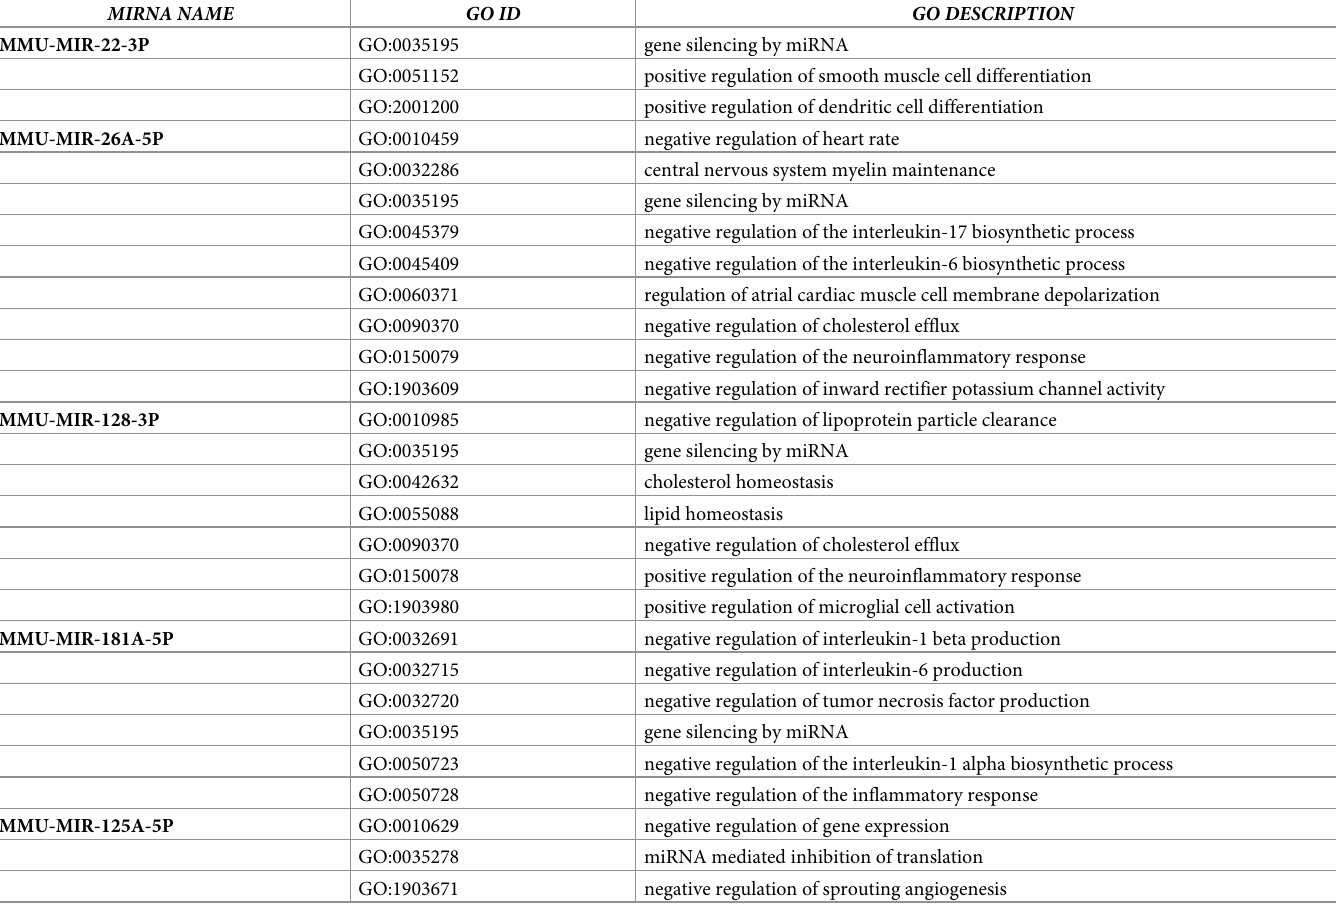
Table 2. The most represented mature miRNAs in mice cortices. The mature miRNAs were annotated with Gene Ontology in relation to a biological process using the QuickGO database [27]. MIRNA